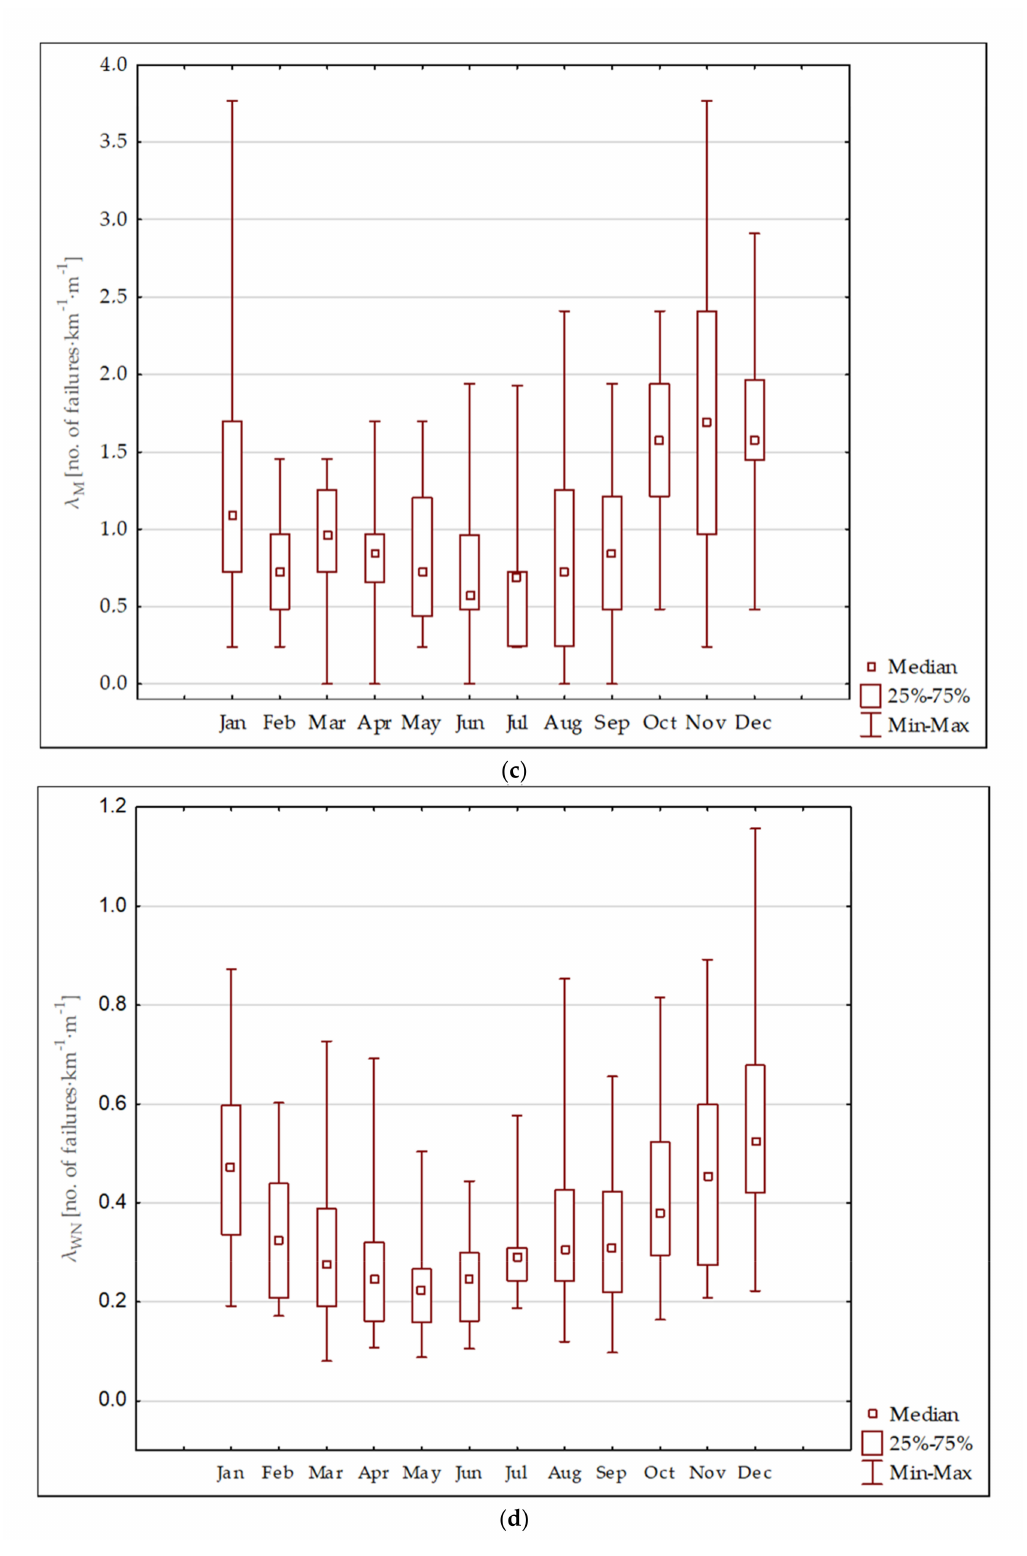
Figure 2. Whisker Plot Box: failure rate averaged per month for: ( a ) distribution pipes, ( b ) water connections, ( c ) mains, and ( d ) the whole water